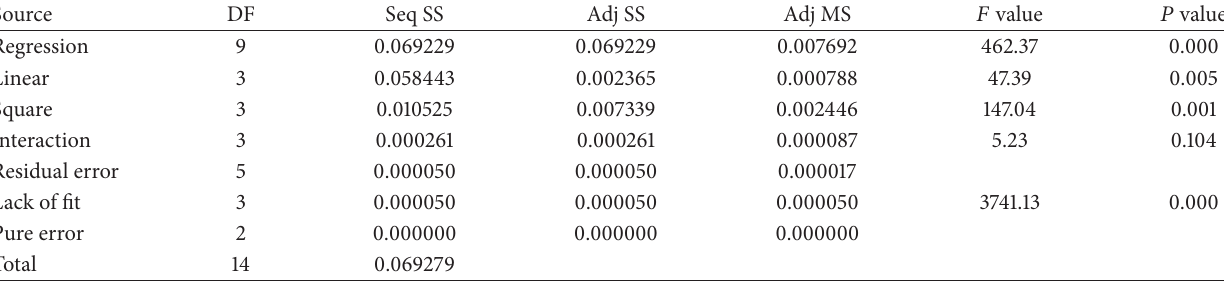
Table 7: Analysis of variance for coefficient of friction (COF).